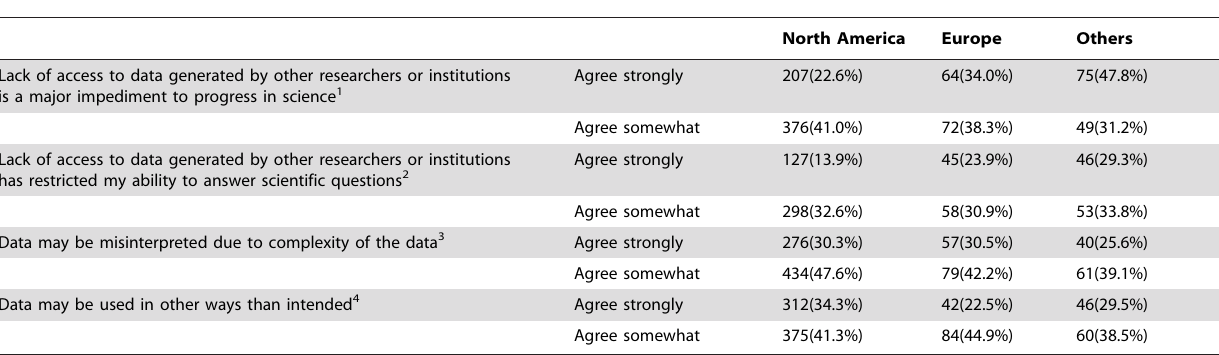
Table 34. Data reuse by geographic